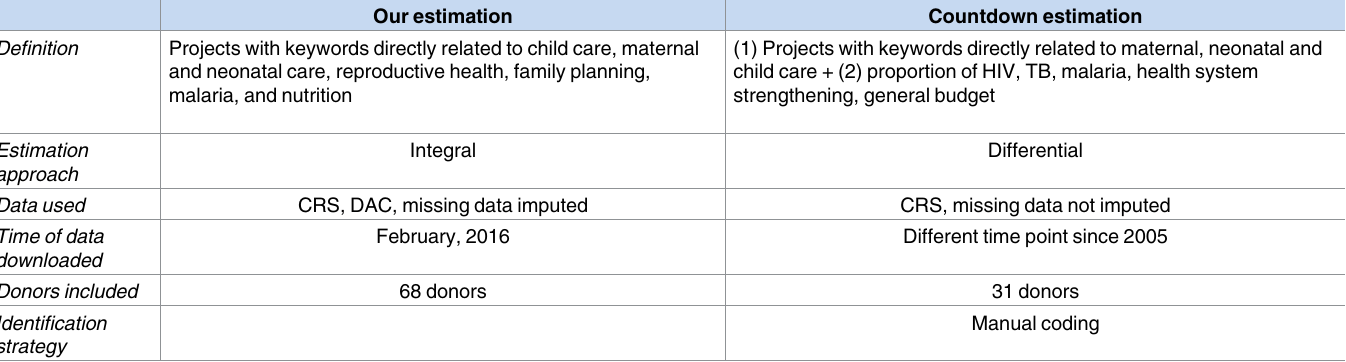
Table 4. Differencebetween our estimation and the countdown estimation. Our estimation Countdown